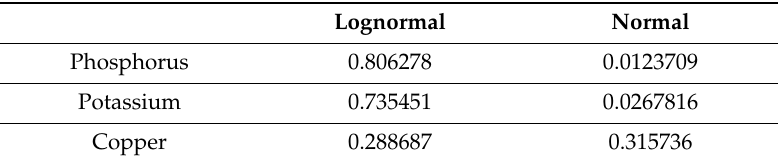
Table 2. P -values obtained for P, K and Cu in PM10 after Kolmogorov–Smirnov